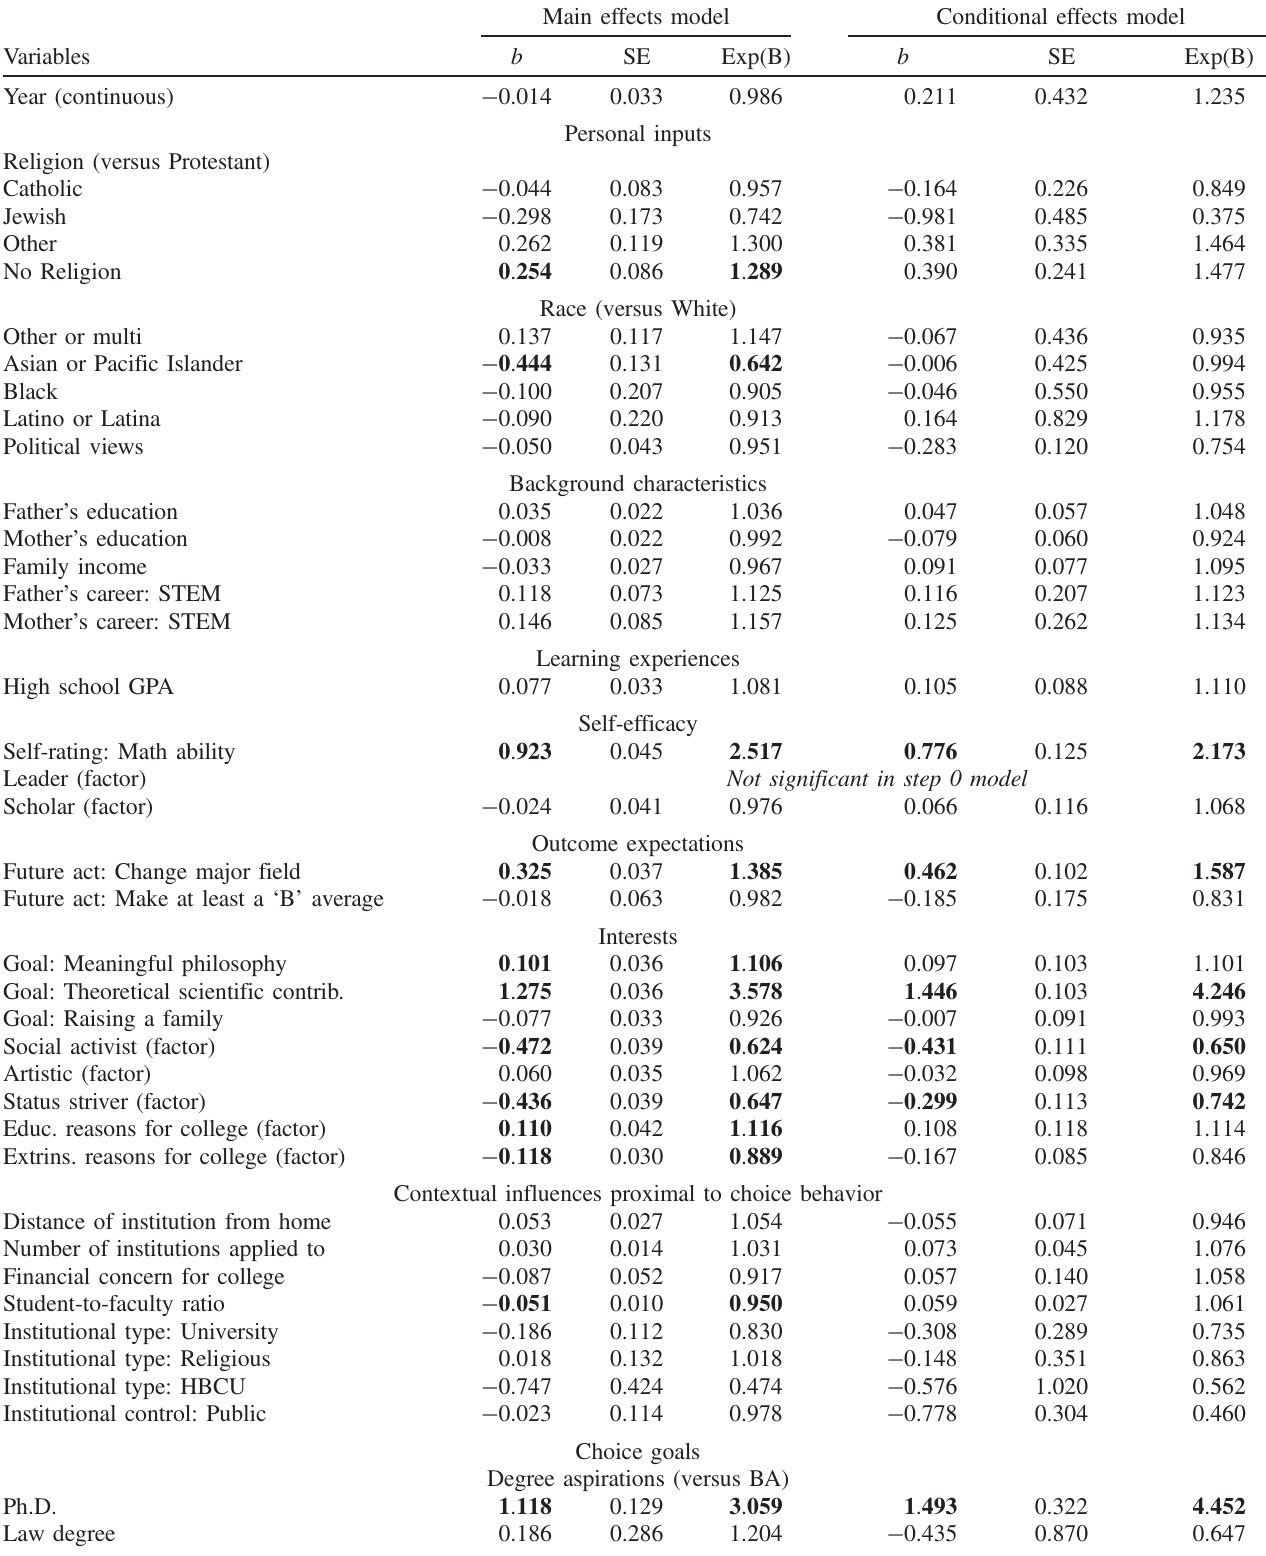
TABLE III. Logistic regression predicting choice of physics major among women ( n ¼ 399 766 ) (compared to all other majors). Bold indicates p < 0 . 01 . Number of physics majors included in this analysis is